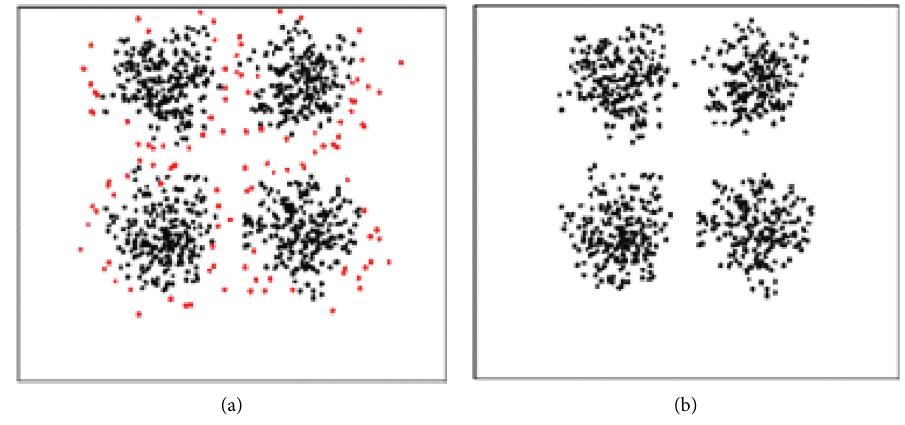
Figure 1: The distribution of deviation point set P and dataset S .